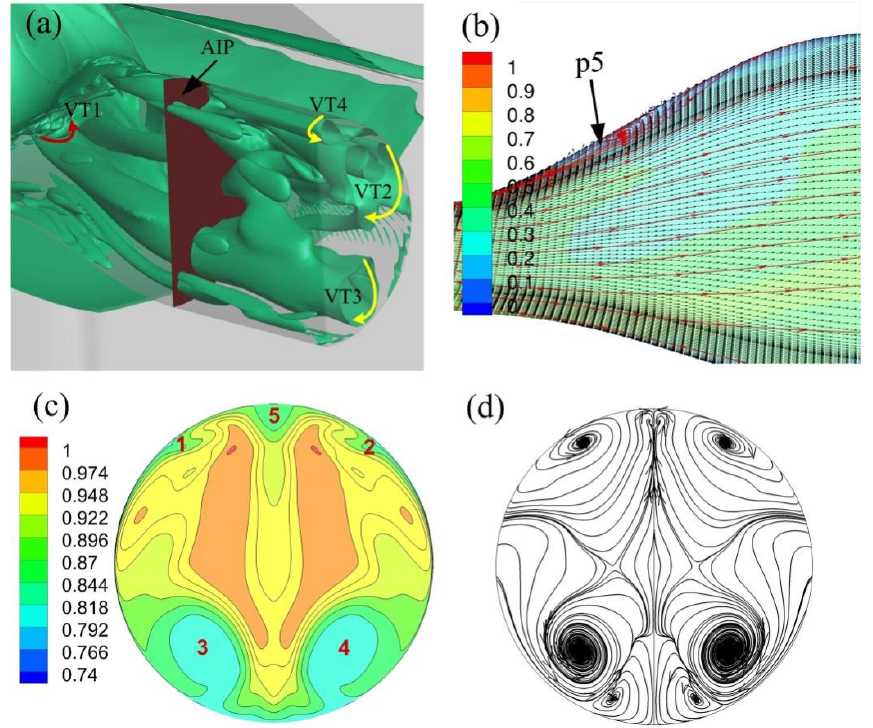
Figure 10. Flow field characteristics of the serpentine inlet at M = 0.235 and p AIP / p 0 = 0.85 under the no-gust condition: ( a ) the vortex tube (VT) structure, ( b ) Flow separation occurring at the lee side of the top surface coupled with the Mach number contour, ( c ) Total pressure contour at the AIP, and ( d ) Pattern of the secondary flow at the AIP.